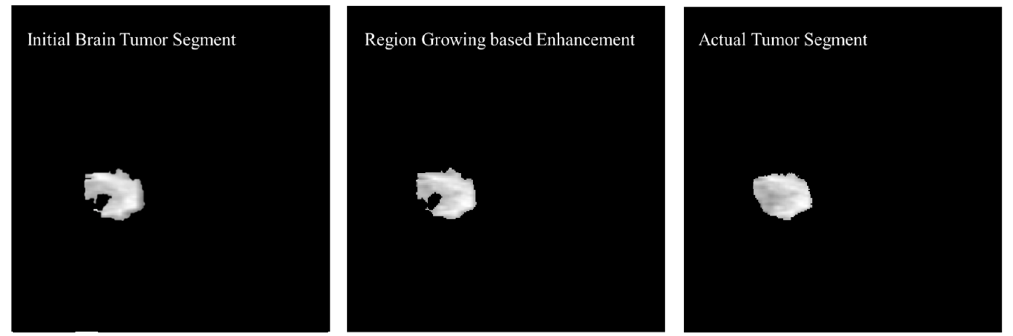
Figure 14. Enhancement in the initial brain tumor segment by applying region growing method and visual comparison with the actual tumor segment.